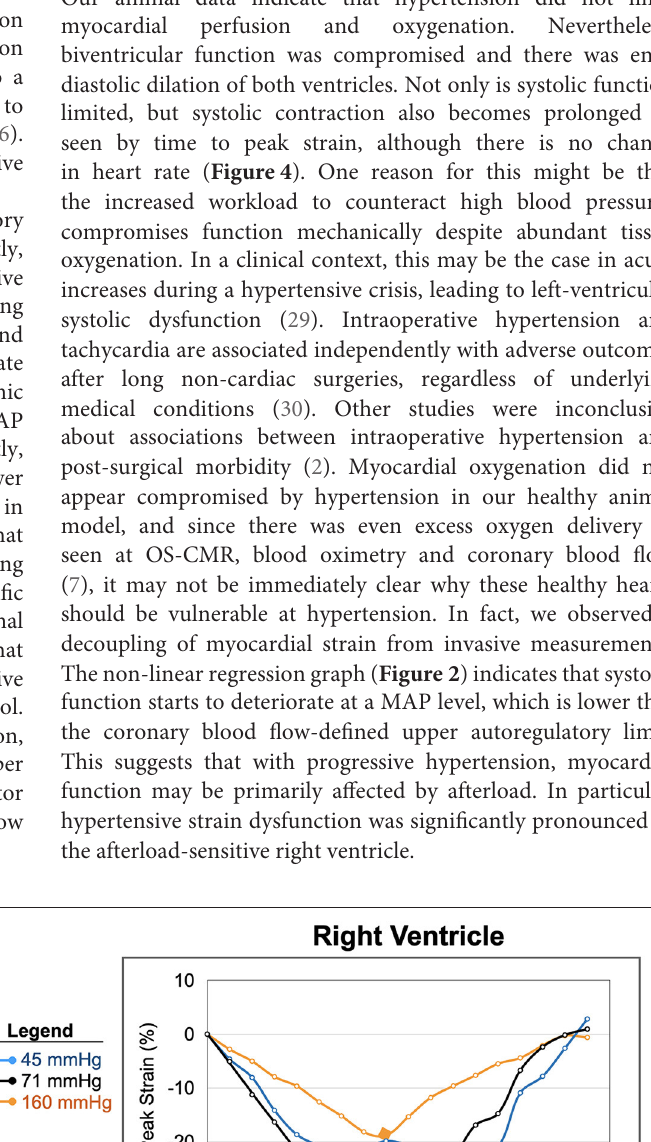
Frontiers in Cardiovascular Medicine |